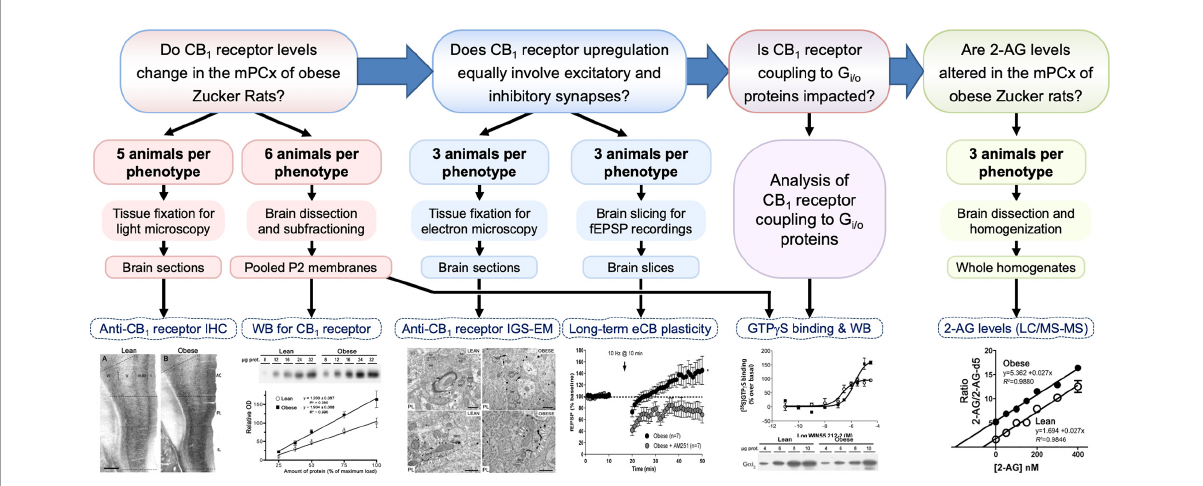
FIGURE1 Diagram summarizing the workflow, sample size and processing, and experimental approaches to answer the four main questions (framed boxes at top) posed in this study. 2-AG, 2-arachidonoylglycerol; eCB, endocannabinoid; fEPSP, field excitatory postsynaptic potential response;